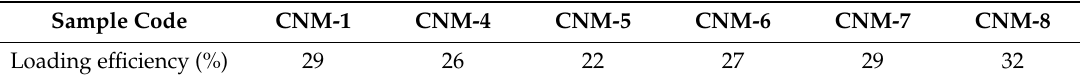
Table 3. The5-FU encapsulation efficiency values.